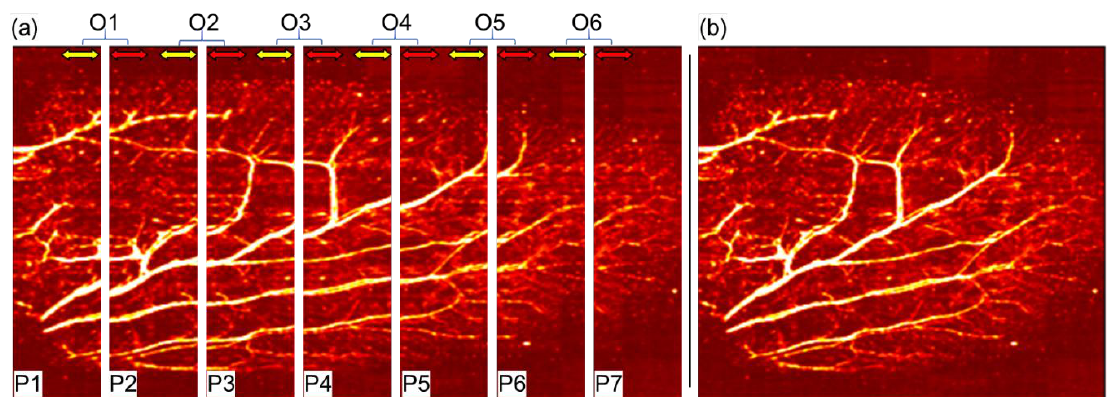
Figure 4. Dataset of the mouse ear OR-PAM imaging patches and whole OR-PAM images. ( a ) Maximum amplitude projection (MAP) of 7 OR-PAM imaging patches with an overlapping range between duplicated area 01–06 arranged by left patches (yellow arrow) and right patches (red arrow). ( b ) Merged patches into a single projection manually.